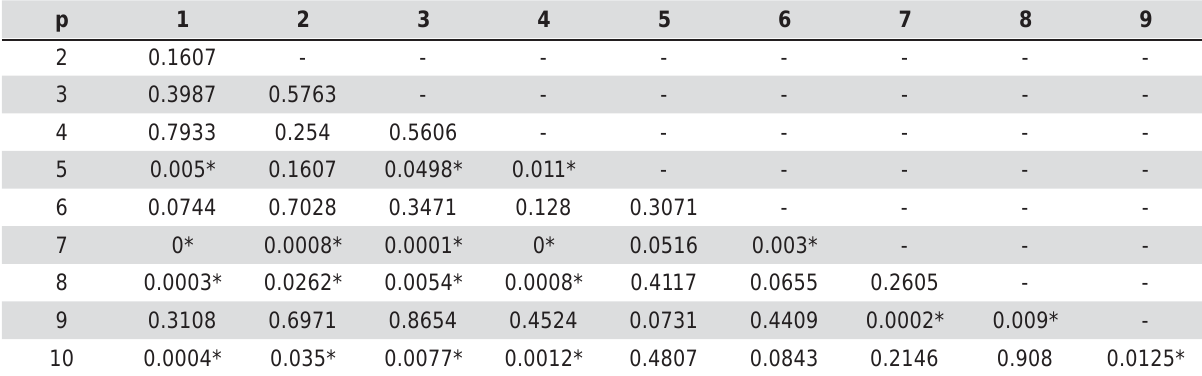
*statistically different